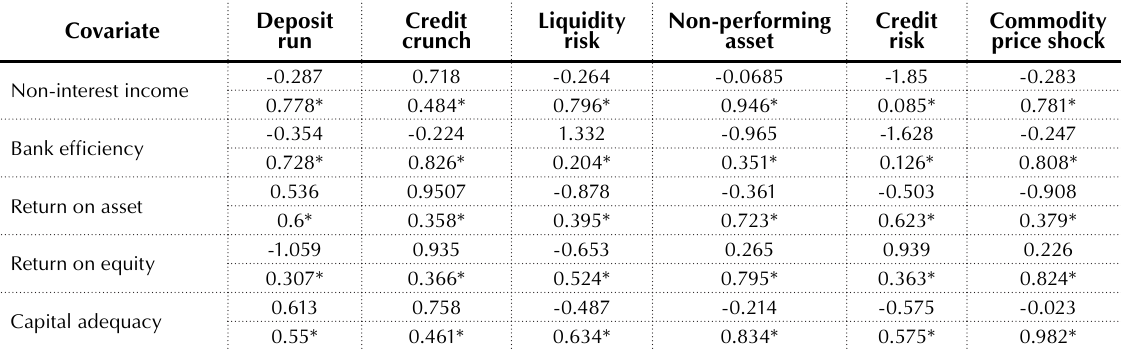
Table 17. Linear combination for canonical correlation